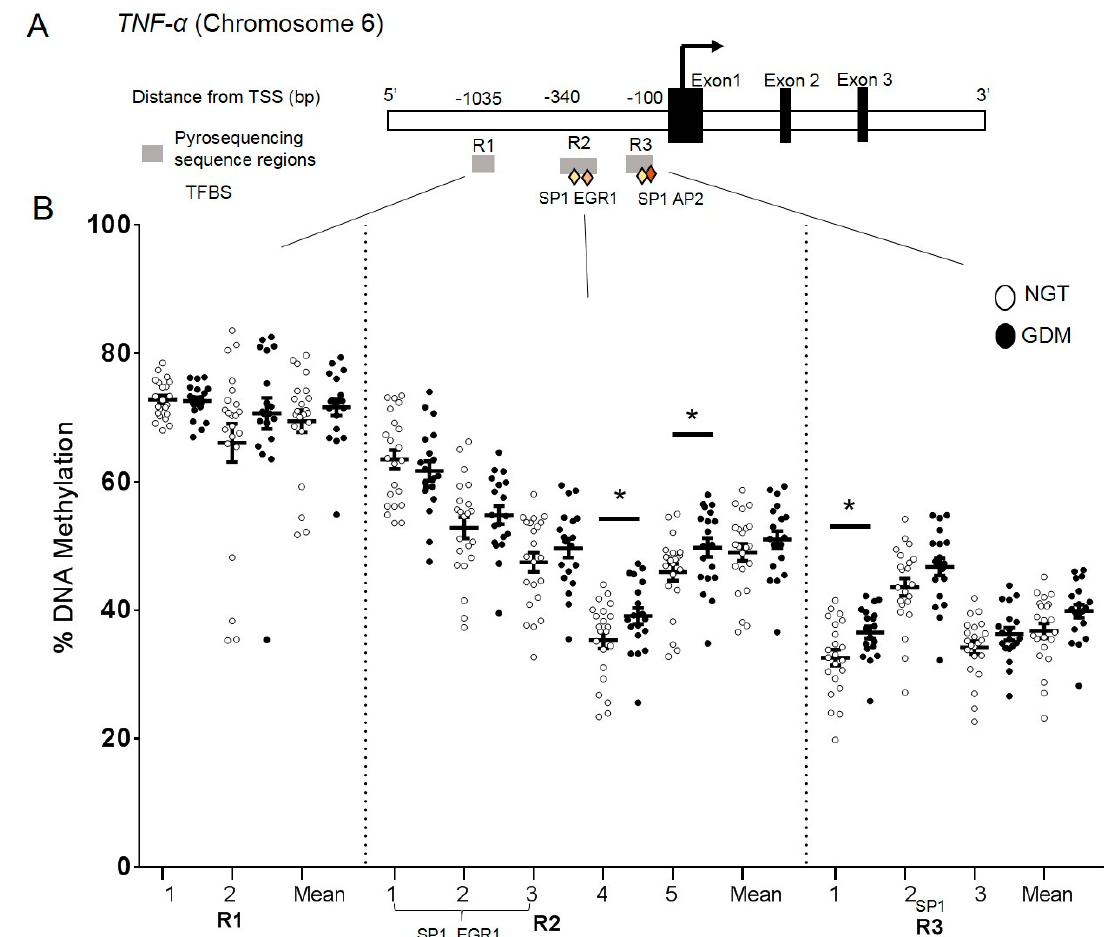
Figure 2. DNA methylation analysis in the TNF - α promoter region. CpG site-specific DNA methylation analyses at the TNF - α promoter region in visceral adipose tissue from mothers with NGT vs. GDM. ( A ) Schematic illustration of the DNA methylation assays (R1, R2, and R3) for the TNF - α promoter region, including transcription factor binding sites (TFBS) Sp1, EGR1, AP2 (diamonds). ( B ) Percent DNA methylation at each individual CpG site investigated (10 CpG sites) in VAT of normal glucose tolerant (NGT; white; n = 22) vs. GDM group (GDM; black; n = 19). Overall mean across CpG sites is also included. Data are means ± S.E.M. * P < 0.05. TSS: Transcriptional start site, bp: basepairs.